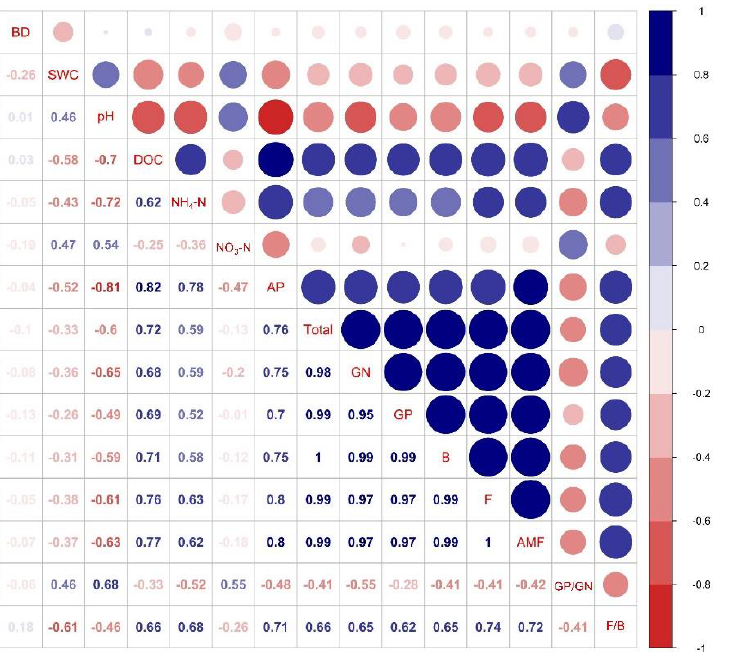
Figure 4. Pearson correlation coefficients (r) between soil microbial PLFAs and soil physicochemical properties at 0–10 cm soil in pomegranate plantation of different years. (Total: total PLFAs; GN: Gram-negative bacterial PLFAs; GP: Gram-positive bacterial PLFAs; B: bacterial PLFAs; F: fungal PLFAs; AMF: arbuscular mycorrhizal fungal PLFAs; GP/GN: the ratio of Gram-positive bacterial PLFAs to Gram-negative bacterial PLFAs; F/B: the ratio of fungal PLFAs to bacterial PLFAs; BD: bulk density; SWC: soil water content; DOC: dissolved organic carbon; AP: available phosphorus; Blue color represents positive correlation; red color represents negative correlation; bubble sizes represent the values of r). Table 2. Statistical significance of the effects of stand ages, soil depths and their interactions on soil properties and soil microbial communities (two-way ANOVA).